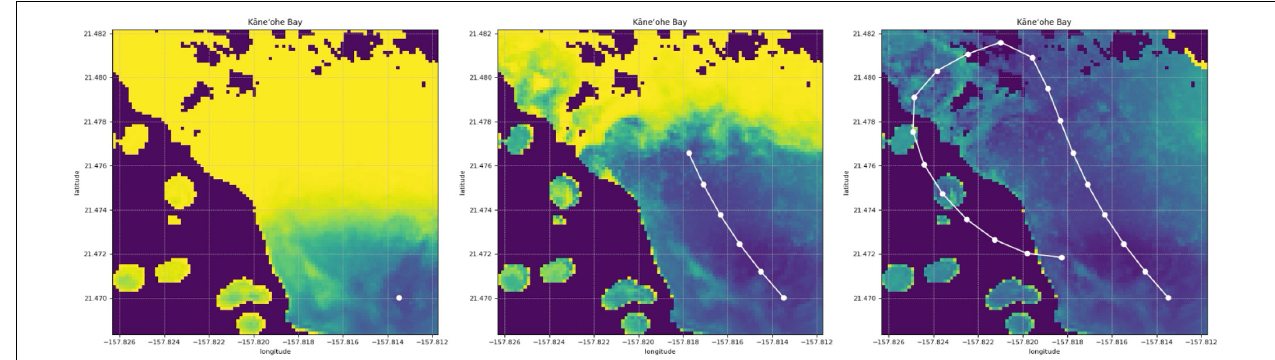
FIGURE 8 | Visualization of the uncertainty of the model in Kaneohe Bay in terms of Shannon entropy. Light/yellow tones indicate high uncertainty areas, whereas dark blue tones denote low uncertainty. The mapping process starts with high uncertainty throughout the map (left) . Uncertainty decreases as more samples are collected (center) . Uncertainty is propagated throughout the scene as a function of spectral and spatial similarity in remote sensing data. Eventually there is little uncertainty left in most of the map due to the efficient extrapolation of representative samples (right) .